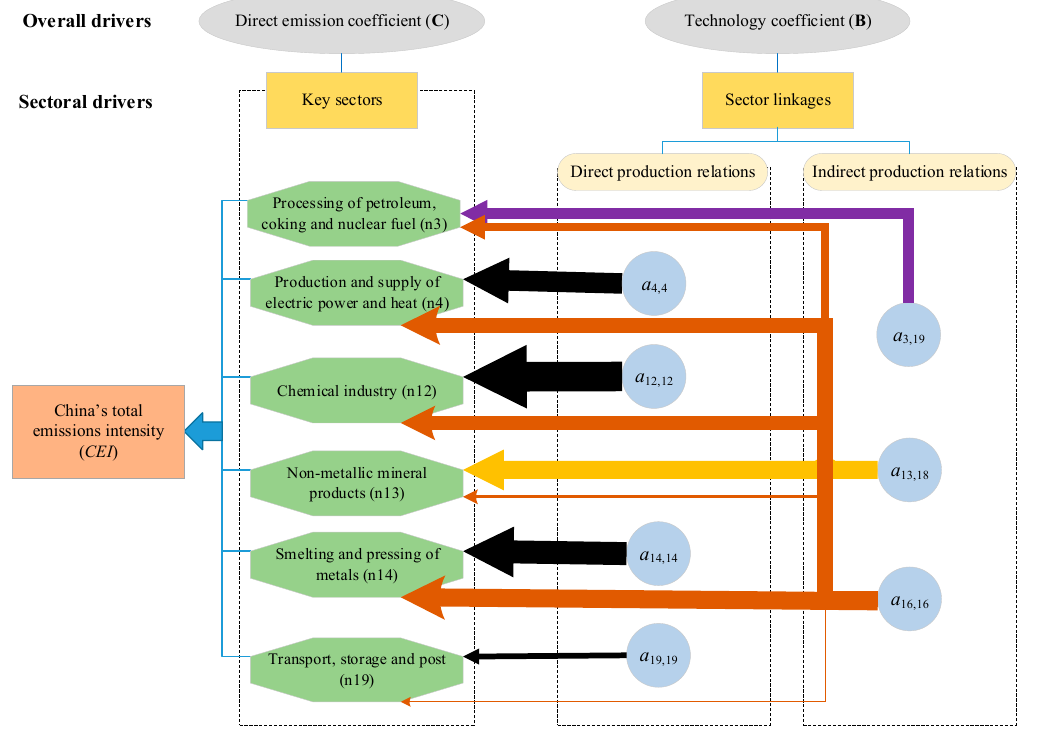
Figure 5. Map of hotspots in China’s energy system leading to the highest potential emissions. The notation a i,j indicates the technical coe ffi cient, i.e., the direct consumption of sector j by unit input of sector i , with its “structure-relevant” technical coe ffi cient elasticity reflected by the width of the corresponding arrow. The direction of an arrow presents the subordination from a key involved coe ffi cient to the higher-level one, with the former impacting the latter greatly (or the latter super-sensitive to the